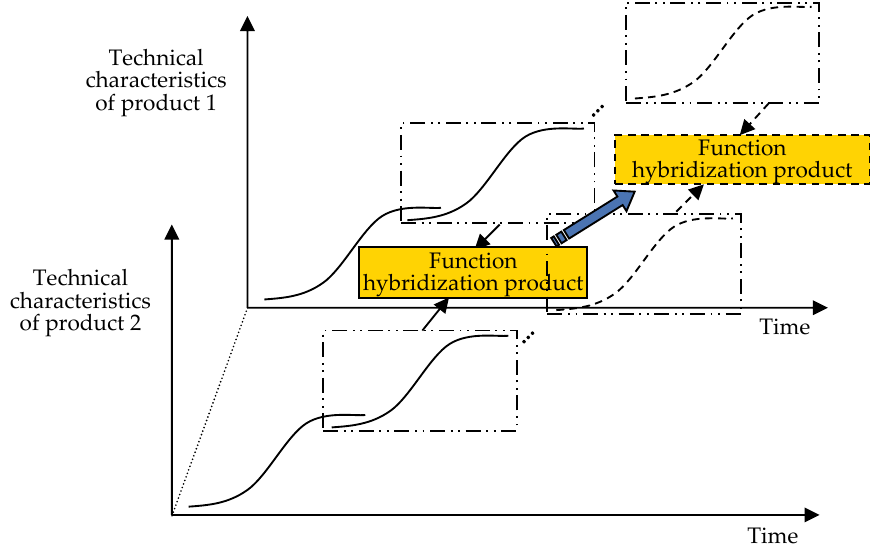
Figure 2. Distant function hybridization.